Question: Condense the content of this figure into a single sentence.
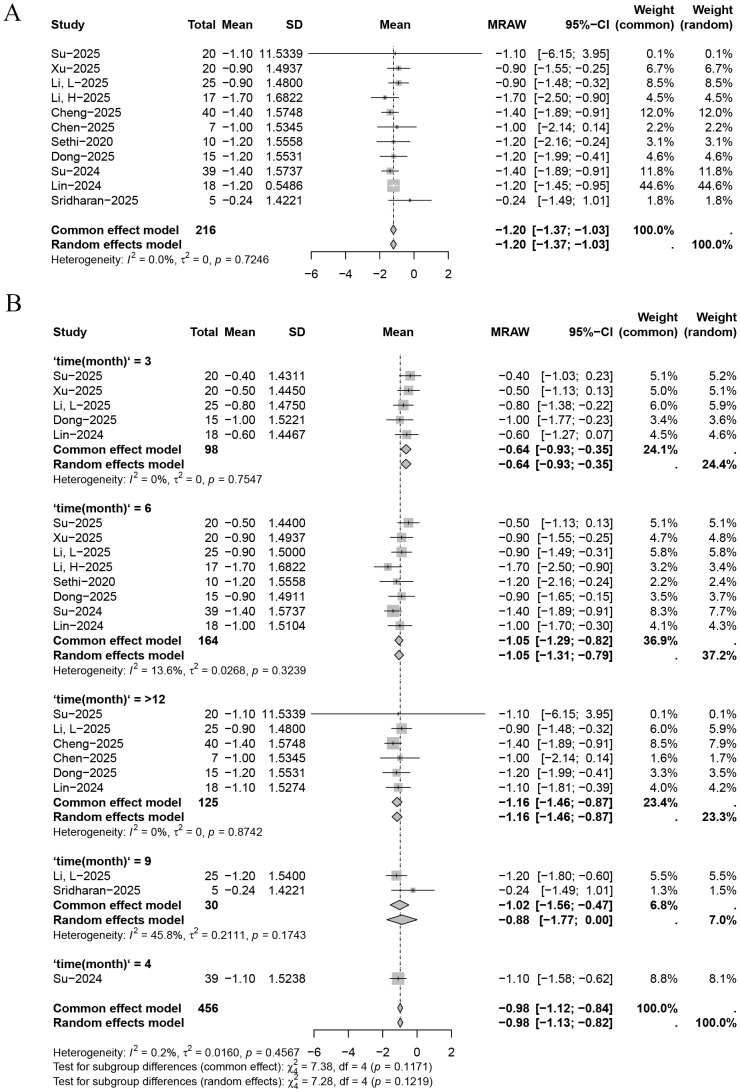
Answer: (A) Forest plot of proteinuria; (B) Forest plot of the subgroup analysis of follow-up time for proteinuria.